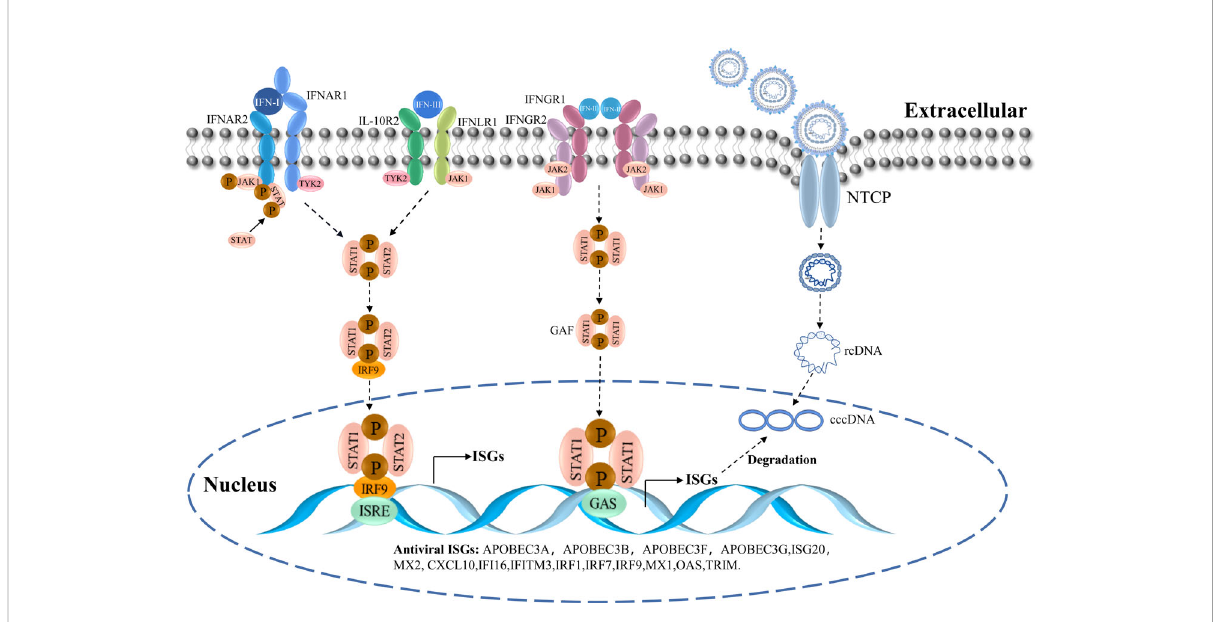
FIGURE 2 The IFN-signaling cascade and the entry of